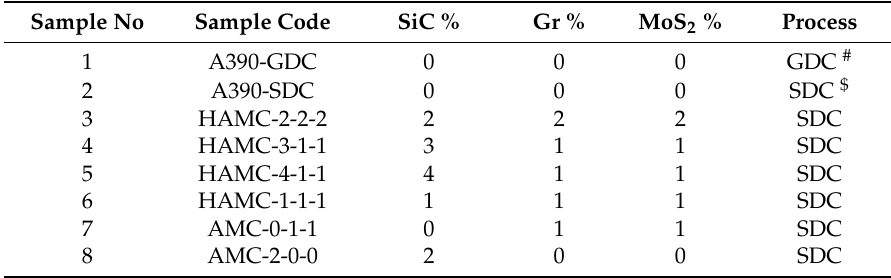
Figure 1. Stir casting setup used for manufacturing HAMCs (Courtesy: SwamEquip, Chennai, India). Table 3. Material samples developed for this investigation.